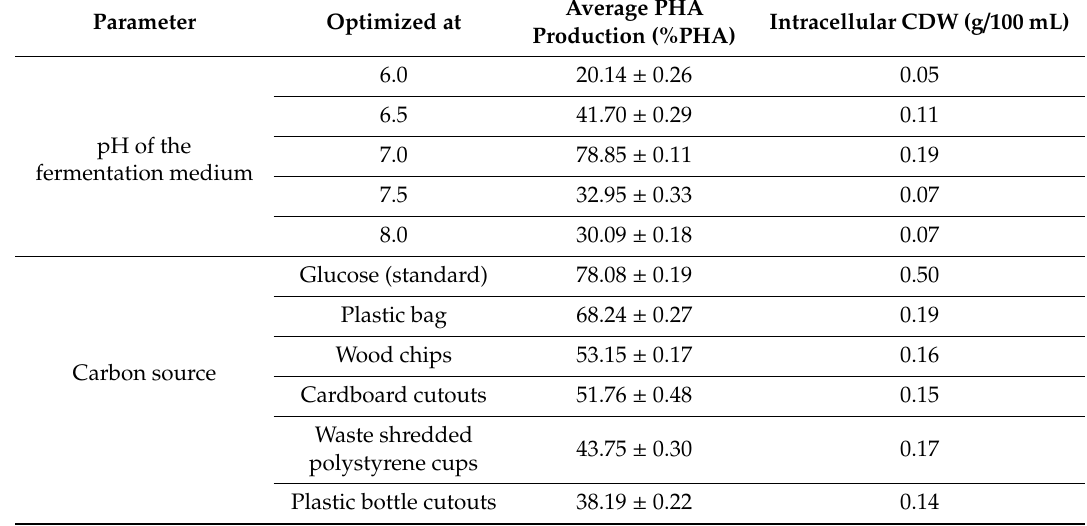
Table 5. Comparison of maximum PHA produced during optimization of various cultural conditions.